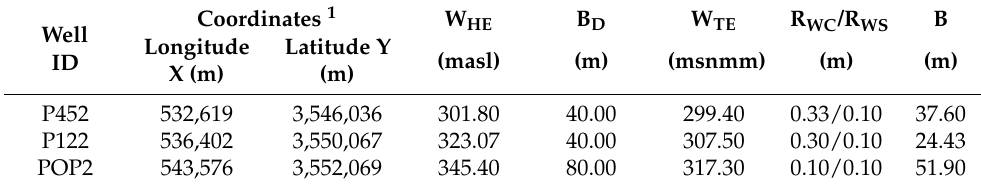
Table 1. Summary of the characteristics of the three monitoring wells studied. Nomenclature: